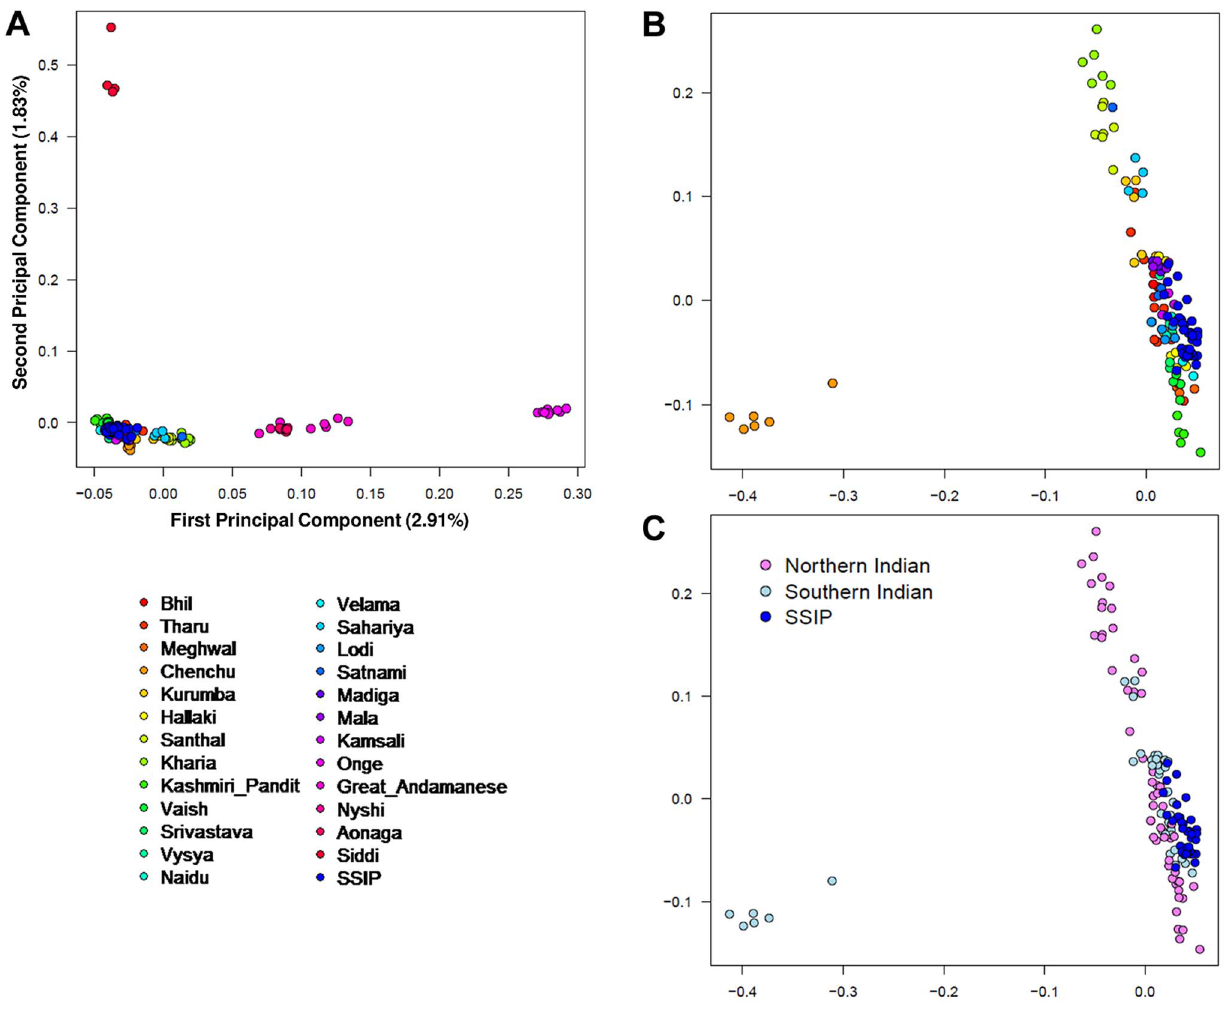
Figure 2. Principal component analysis (PCA) of SSIP samples with 132 South Asians. PCA of 36 SSIP samples with 132 South Asian samples from 25 well-defined Indian groups by Reich and colleagues [44] using 202,600 SNPs that were present in both databases (panel A). Five groups corresponding to Great Andamanese, Onge, Nyshi, Aonaga and Siddi were subsequently removed, leaving 104 samples from 20 Indian groups to be analyzed in a second PCA, where the samples were first assigned a color according to their group memberships (panel B), and second by the latitude of origin into North and South Indians (panel C, see Table S2 for the classification of North and South Indians). The color assignments in panels A and B are represented by the color legend on the bottom left of the figure.